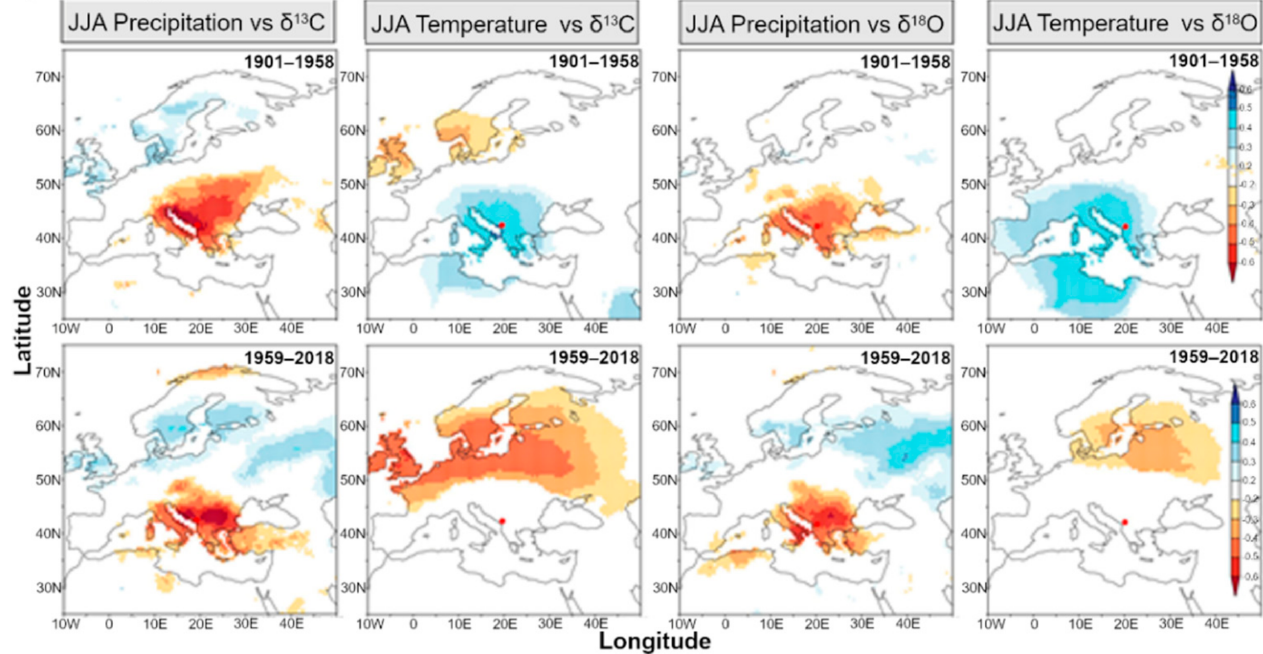
Figure 6. Spatial field correlations between δ 13 C and δ 18 O data and summer (JJA) precipitation sums and mean JJA temperatures for two subperiods. Subperiods are determined based on moving correlation analysis and split calibration- verification results. Spatial correlations between tree-ring stable isotope values and climatic variables were analyzed using monthly gridded data (0.5 × 0.5 ◦ grid) from the CRU TS3.24.01